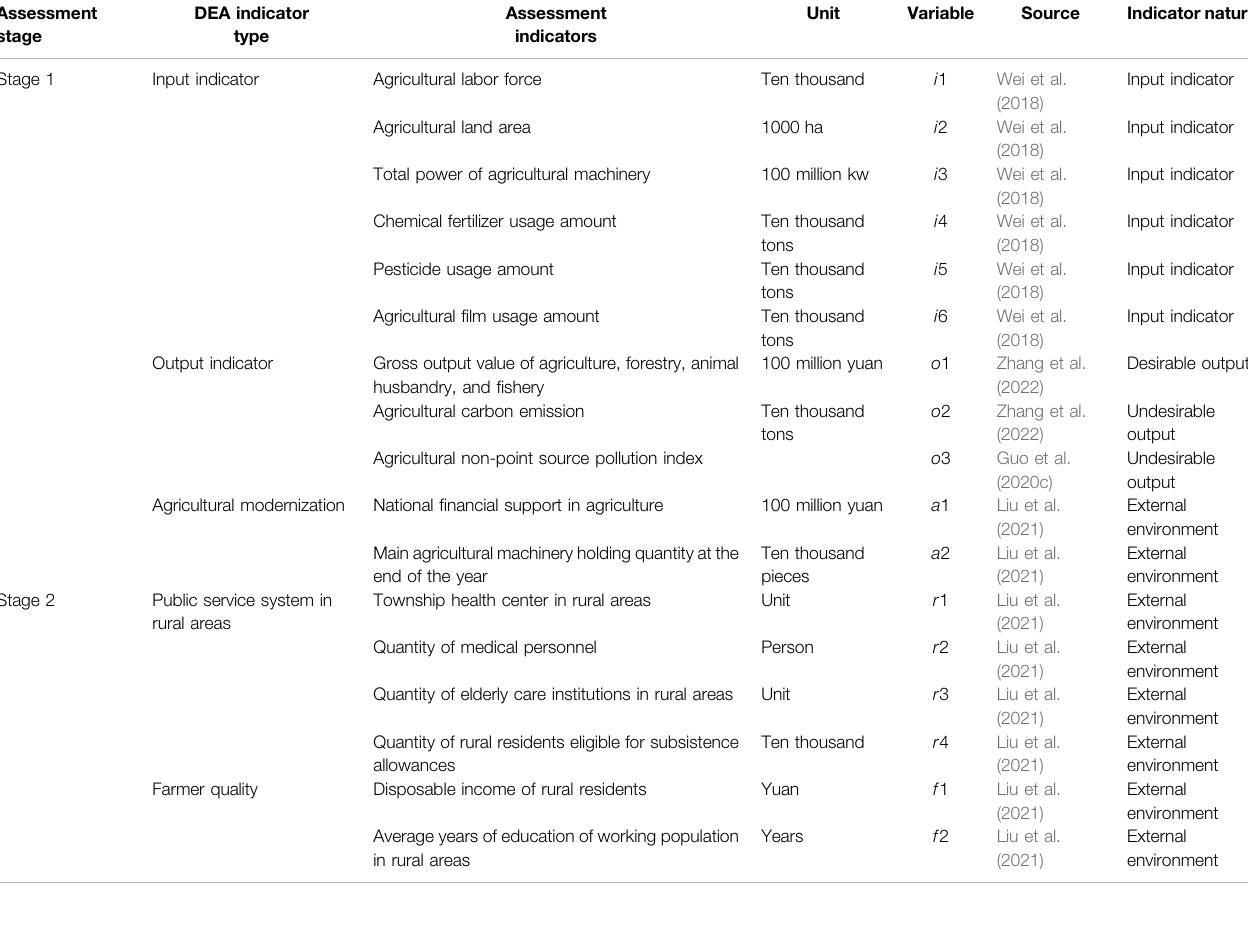
TABLE 1 | Green agriculture development assessment Indicator system. Assessment